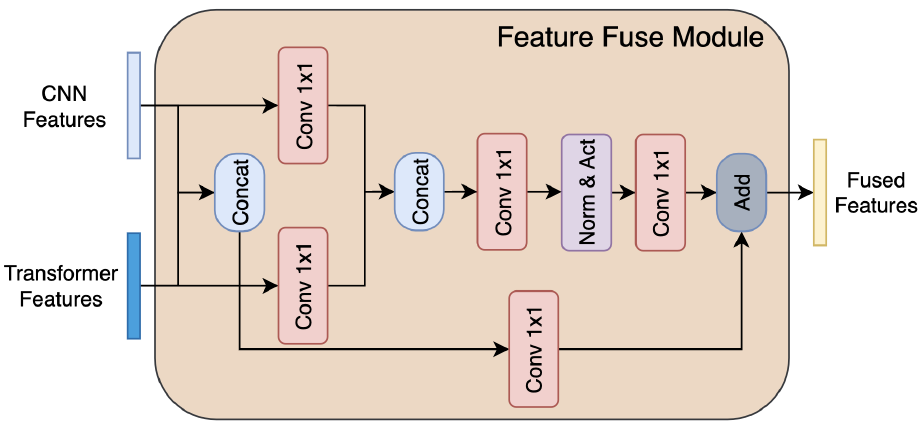
Figure 2. The structure of the proposed feature-fusion